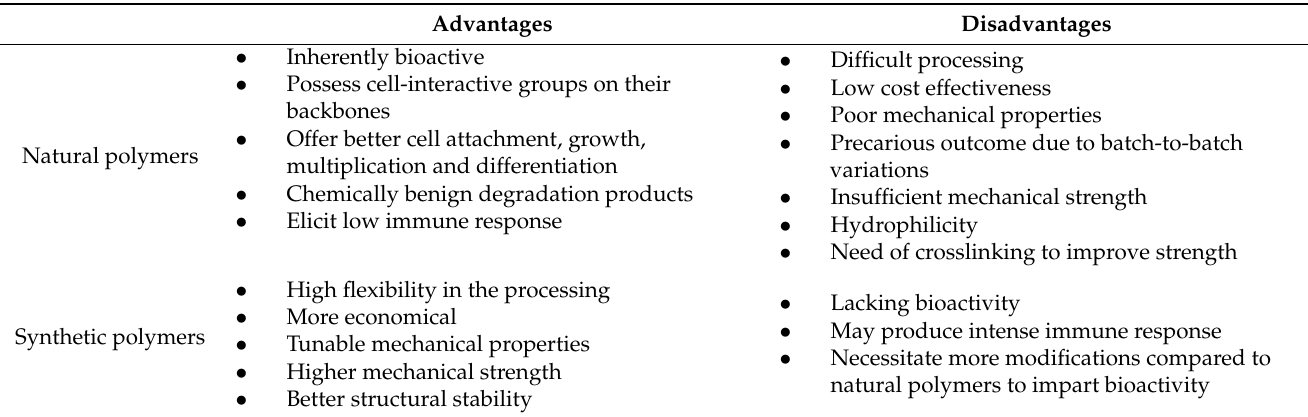
Table 1. Advantages and disadvantages of natural and synthetic polymers.